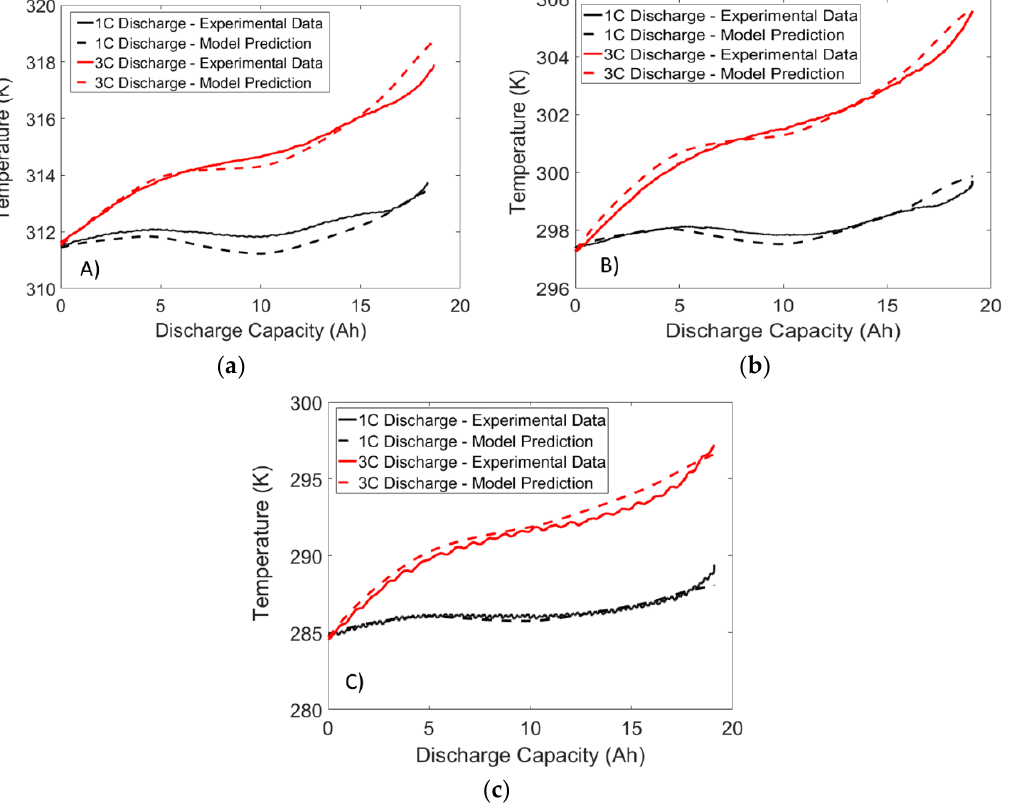
( b ) ( c ) Figure 14. The predicted and simulated voltage profile at 1C and 2C/3C charge for temperatures of: ( a ) 10 °C; ( b ) 25 °C; and ( c ) 40 °C.